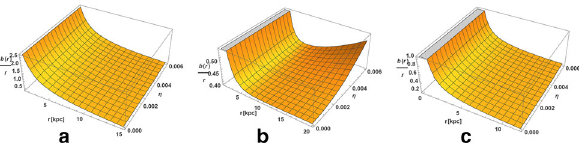
Fig. 2 The ratio b ( r ) with respect to r ( kpc ) and η is plotted by using r − 2 , r ρ = 2 kpc for a NFW profile : r 0 = 0.004 kpc 0 Pseudo-Isothermal profile : r th = 1 kpc , c URC profile : r th = 1 . 1